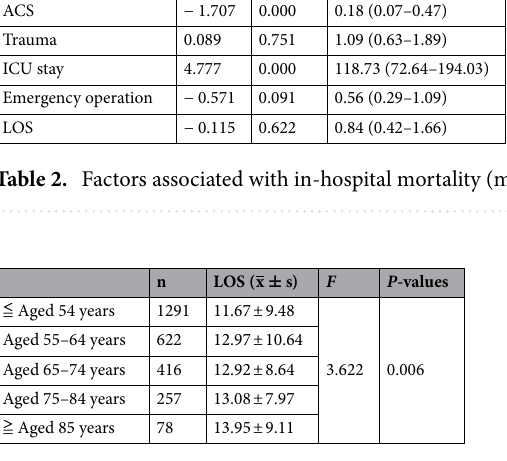
Table 3. Interrelation analysis of LOS and age among postoperative patients. *One-way ANOVA test.